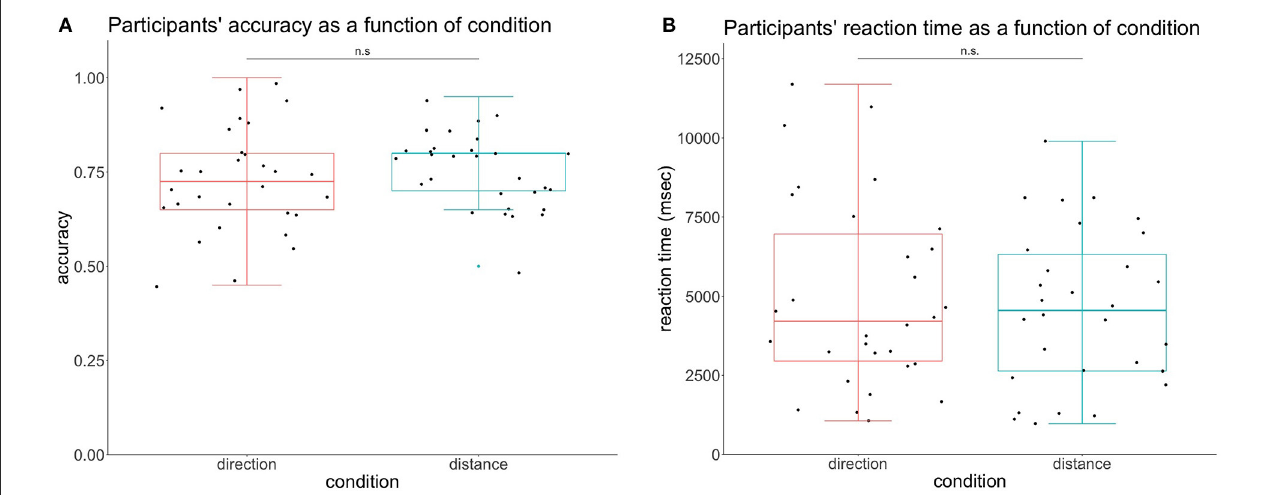
FIGURE1 Participants’ behavioral performance according to the condition. (A) Participants’ accuracy per condition. The accuracy in the condition direction was not significantly different from the condition distance. (B) Participants’ reaction time per condition. The reaction time in the direction condition did not reach the different levels of